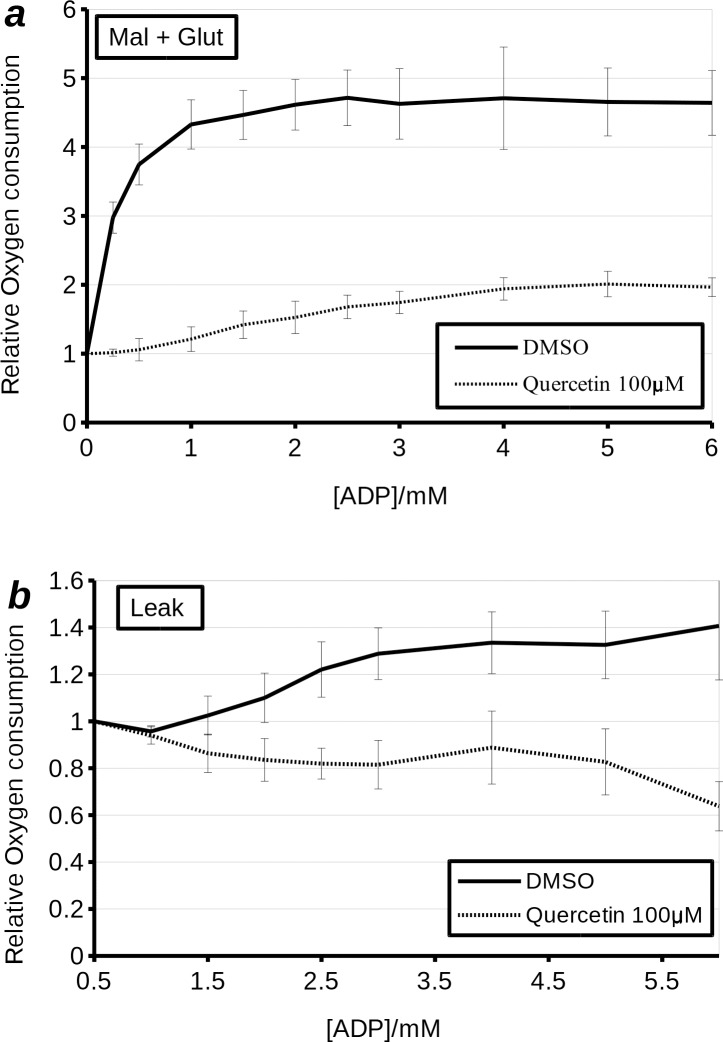
The effect of 100 μM quercetin on complex I (malate + glutamate)- i.e. state III coupled (a) and leak- i.e. state IV (b) respiration in permeabilised H9c2 cells treated with increasing concentrations of ADP. Quercetin appears to dramatically decrease both the Vmax and the IC50 for stimulation of respiration by ADP in permeabilised H9c2 cells (a). The solid black line represents cells titrated with increasing concentrations of ADP in the presence of DMSO. The dashed line represents cells treated with 100 μM quercetin and subsequently titrated with increasing concentrations of ADP.